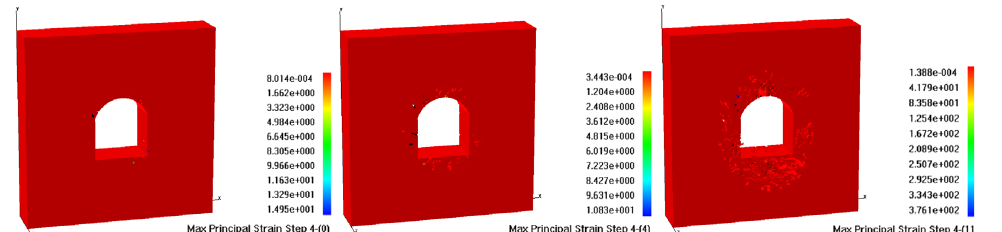
Figure 5. Distribution of the maximum principal strain.